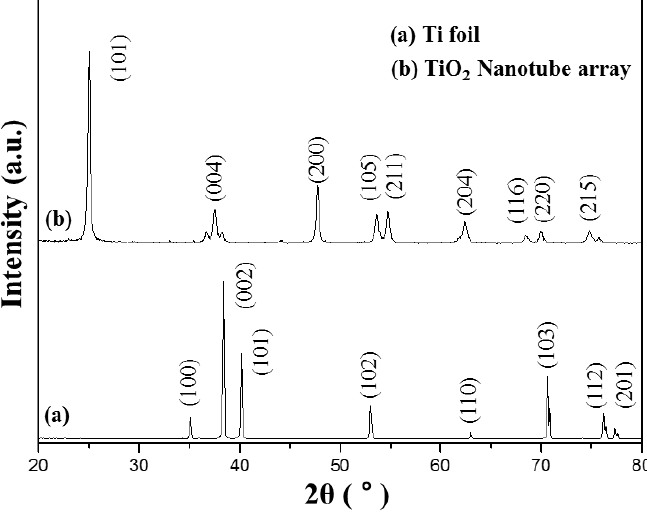
Figure 2. XRD patterns of ( a ) Ti foil and ( b ) a TiO